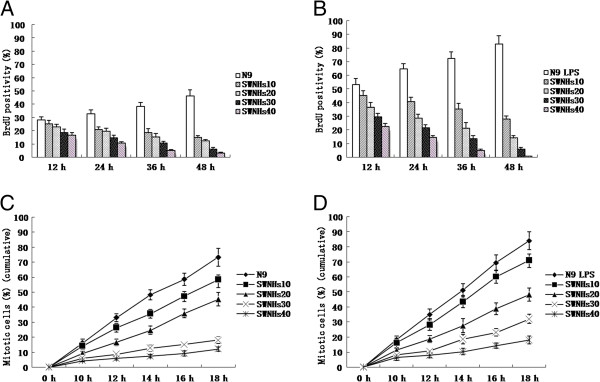
SWNHs inhibited mitotic entry of N9 cells, especially in pre-treated with LPS. To assure how the SWNHs affect cellular mitosis, we incorporated BrdU into the control. We found that the accumulation of mitotic N9 cells pre-treated with or without LPS was significantly delayed by SWNHs at every time point followed with the increasing concentrations of SWNHs (P < 0.01), and the accumulation of mitotic N9 cells pre-treated with LPS (B) were much more than that without LPS (A). The mitotic entry of N9 cells pre-treated with LPS (D) was more than N9 cells (C). SWNHs inhibited mitotic entry of N9 cells pre-treated with or without LPS significantly at every time point followed with the increasing concentrations of SWNHs (P < 0.01). The mitotic entry inhibited by SWNHs in N9 cells pre-treated with LPS (D) was more significant than N9 cells (C). All data are represented as mean ± SEM.